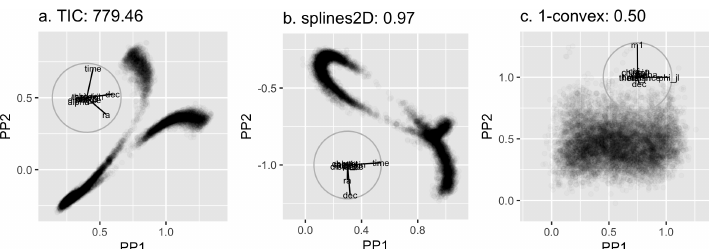
Figure 4. Optimal views of an 11D posterior sample fitting a simulated gravitational wave signal, obtained through projection pursuit optimising the TIC (left), splines2d (middle) and 1-convex (right) index function. The first two views show structure, while the 1-convex index failed to find anything